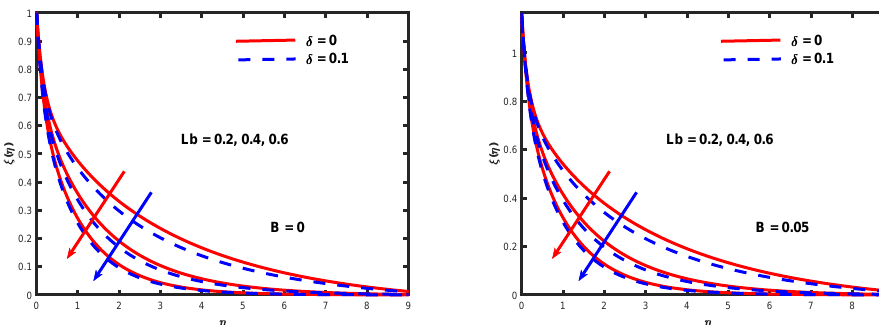
Figure 16. Influence of unsteady parameter and microorganism concentration difference on ξ .